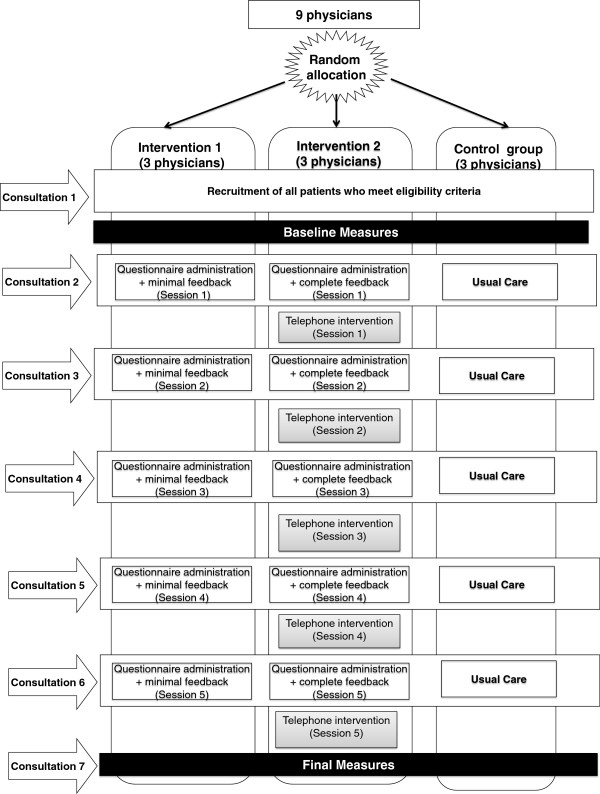
Study procedure.